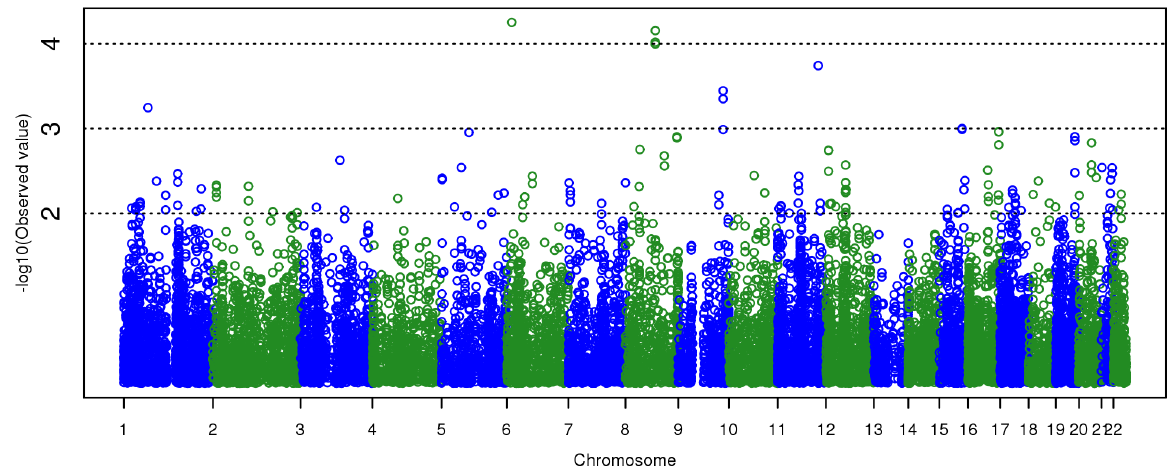
Figure 3. Manhattan plot for gene-based p -values from VEGAS . Analysis input was GWAS p -values from 2,485,149 autosomal SNPs, both observed and imputed. Abscissa position of each point is the gene’s beginning base-pair position, NCBI genome build 36. Genome-wide significance is –log 10 ( p ) . 5.55, which no gene reaches.